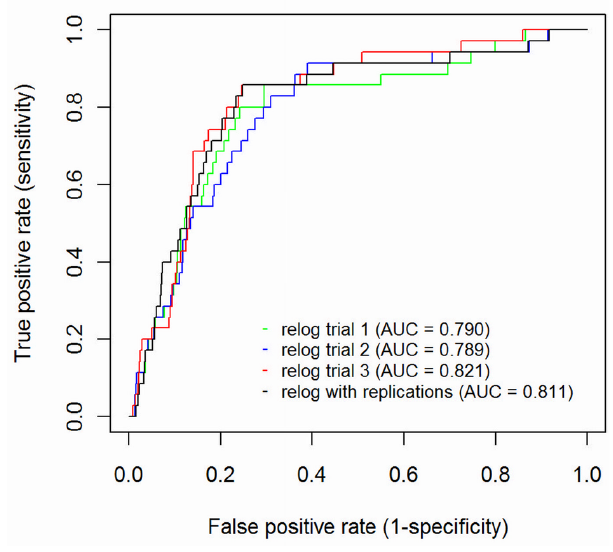
Fig. 5. ROC plot and AUC of validation datasets ( n = 19250) for the different rare event logistic regressions (details of them in Ta- bles 3 and 4 –